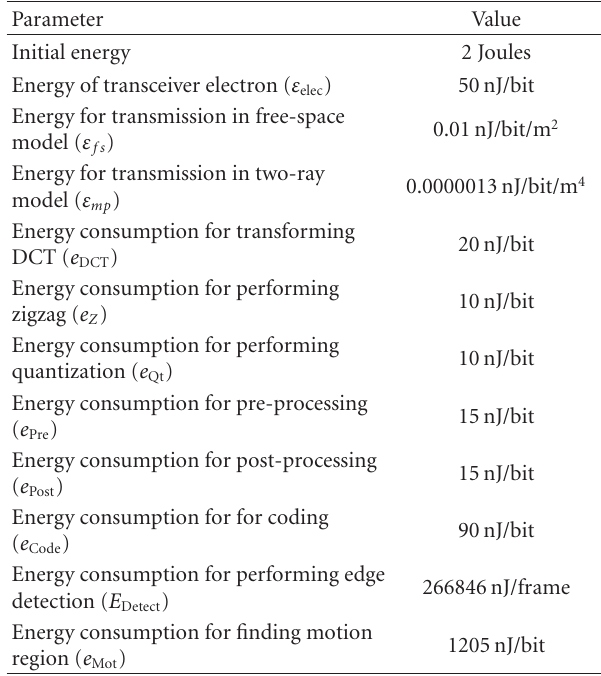
Table 1: Energy parameters using in the